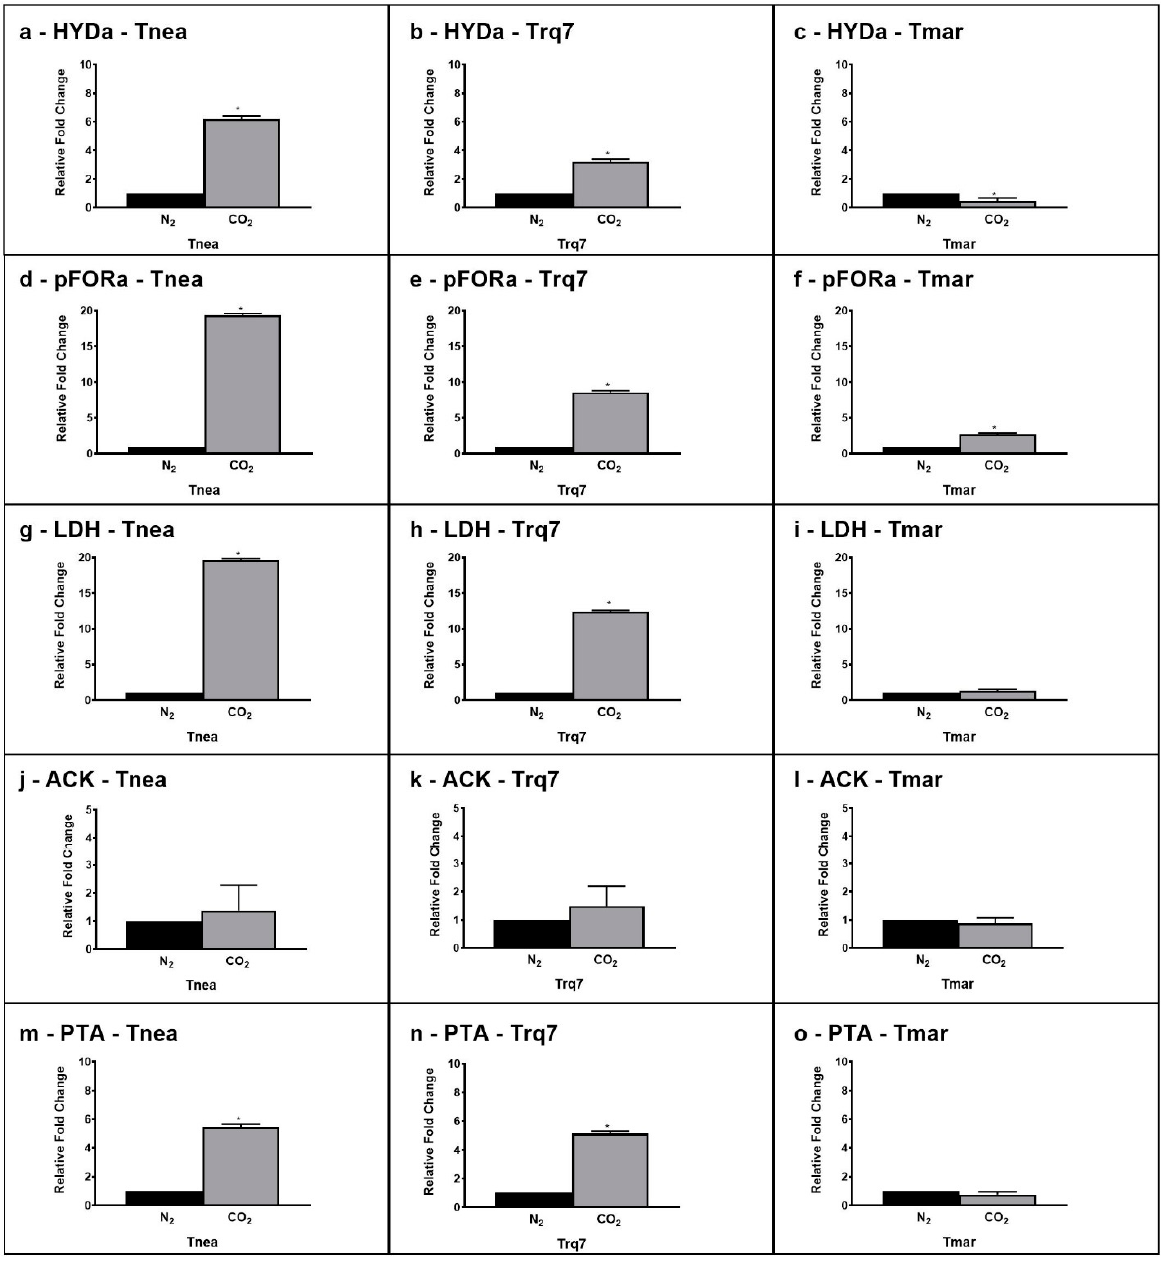
Figure 5. Gene expression levels of HYD (CTN_RS05285 ( a – c )), PFOR (CTN_RS03385 ( d – f )), LDH (CTN_RS03950 ( g – i )), ACK (CTN_RS02020 ( j – l )), and PTA (CTN_RS07210 ( m – o )) after 24 h under N 2 (black bars) and CO 2 (gray bars) conditions in Tnea, Trq7 and Tmar . Variations are indicated as relative fold changes in CO 2 with respect to N 2 . mRNA levels were calculated relative to the expression of 16S RNA. Asterisks indicate significantly different values at p ≤ 0.05 (*).